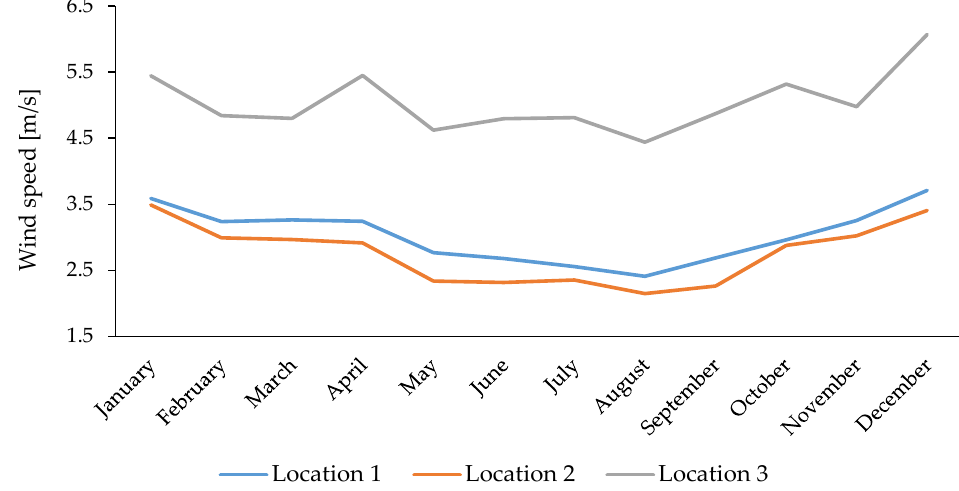
Figure 6. Distribution of mean monthly wind speeds across the period 2014–2018 for the three locations. Figure 7 presents the monthly wind speeds averaged among the three locations for each year analyzed. The raw data are provided in Appendices A and B. Each year is different; no two diagrams are identical. Although the individual diagrams intersect and even overlap, the discrepancies are rather significant and obvious.